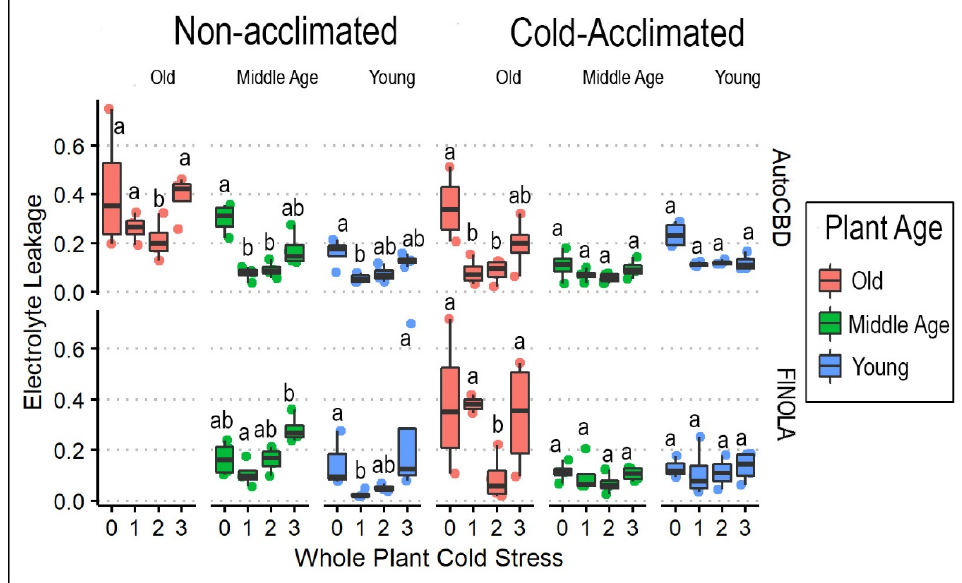
Figure 3. EL WP box plots comparing whole-plant cold stress and plant age for cold-acclimated and non-acclimated ‘AutoCBD’ and ‘FINOLA’ plants. Electrolyte Leakage represents the ratio between electrical conductivity (EC) of leaf sample after whole-plant cold stress and EC of leaf sample after cell lysis. Non-acclimated plants received no cold acclimation period, and acclimated plants were subject to 10 days at 10 °C. Cold stress consisted of no exposure, 0 (control); a single 3 h − 0.5 °C exposure, 1 ; two consecutive 3 h − 0.5 °C exposures separated by 24 h, 2 ; and three 3 h − 0.5 °C exposures separated by 24 h, 3 . Plant age treatments include oldest plants, middle-age plants, and youngest plants (68, 54, and 40 days old on the day of whole-plant cold stress, respectively). Lowercase letters indicate significant differences ( p < 0.05) between treatments (Tukey’s test).